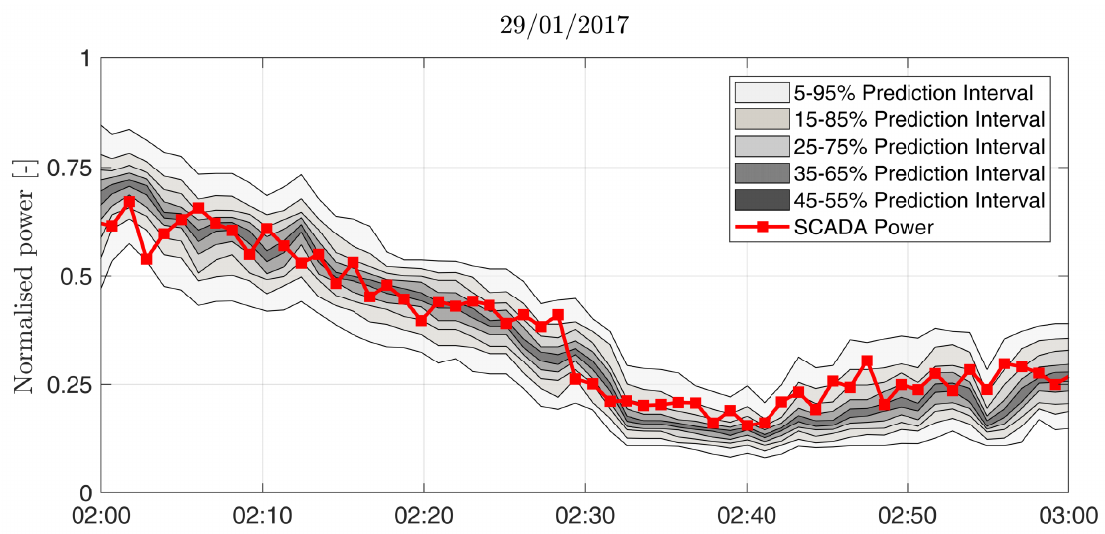
Figure 10. A 60 min episode of five-minute ahead predictions of normalised power for WT 3 with the remote sensing-based forecasting model (RF). Prediction intervals are shown together with the observed power (red